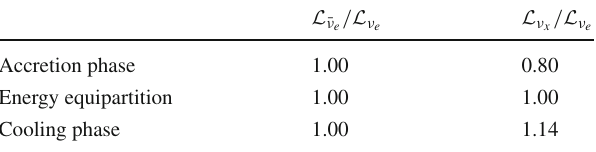
Table 1 The luminosity ratios between different flavors for three spe- cific scenarios